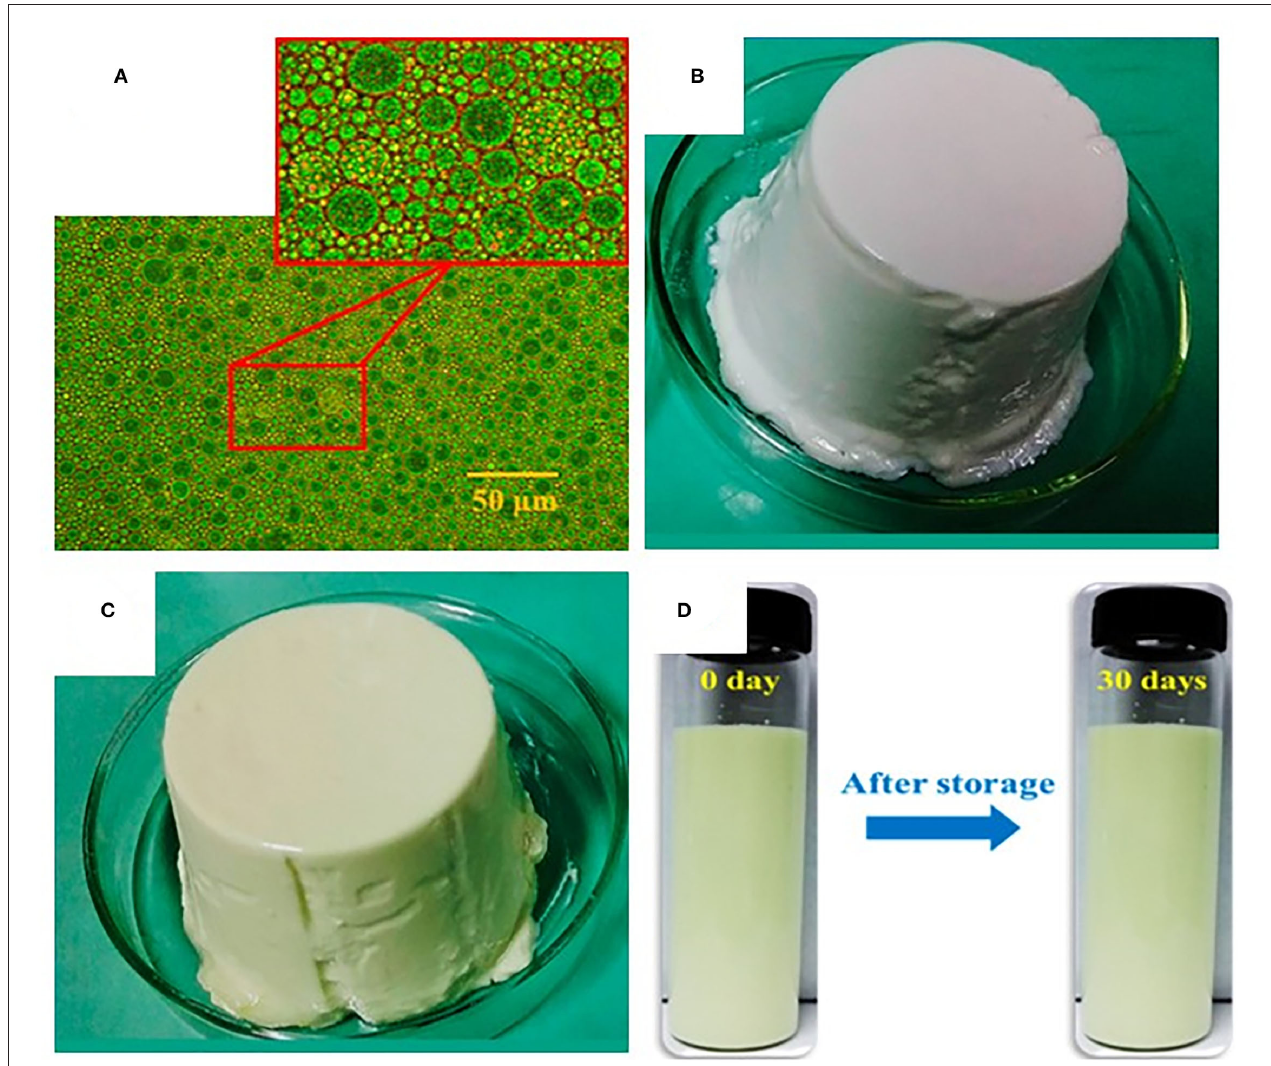
FIGURE 4 | Optical microscopic image and visual appearances of emulsion gels; (A) Emulsion dispersion droplets, (B) Blank emulsion gel, and (C) Epigallocatechin-3-gallate and quercetin co-loaded emulsion gel. The formed gel showed an encapsulation efficiency of 65.5 and 97.2%, whereas enhanced the bioaccessibility by 48.4 and 49% for (-)-epigallocatechin-3-gallate and quercetin, respectively. In addition, emulsion gel showed lower release rates of 73.3 and 31.7% and improved stability by 63.6 and 82.3% for epigallocatechin-3-gallate and quercetin after 8-h incubation in specific environmental conditions (simulated intestinal fluid) and remained stable to phase separation during 30-days storage at 4 ◦ C (D) (103).